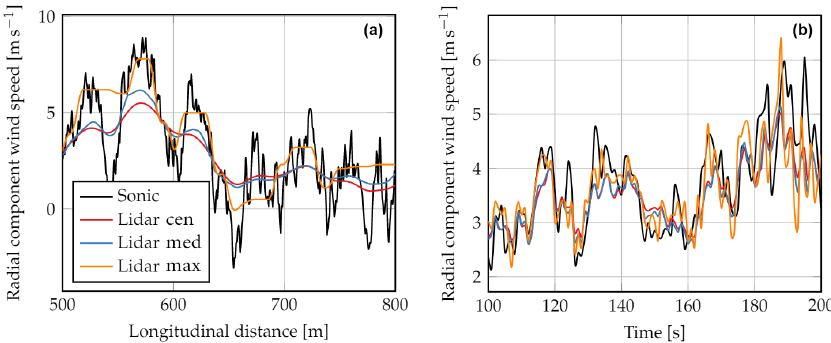
Figure 3. Example data for the numerical simulation ( b ) and the experiment ( a ).